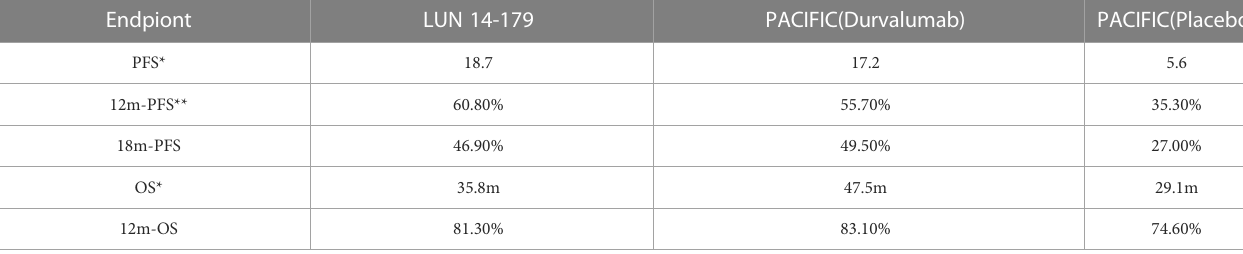
TABLE 2 Ef fi cacy results of consolidation immunotherapy for LUN 14-179 and PACIFIC trial.